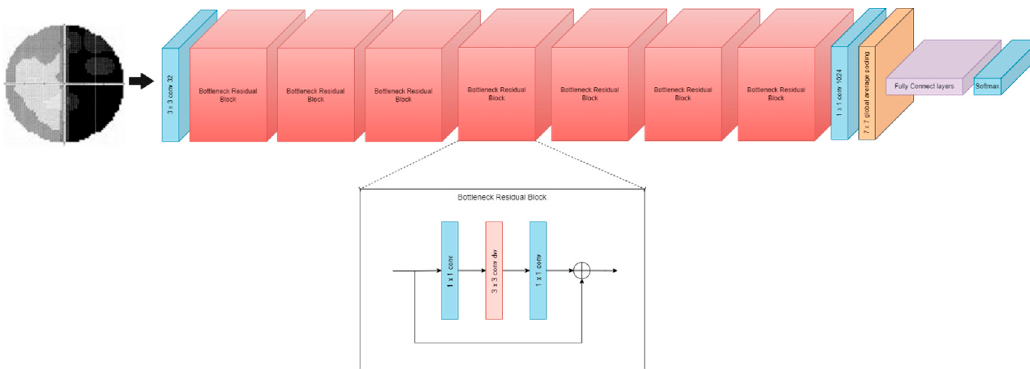
Figure 7. MobileNetV2 Model.